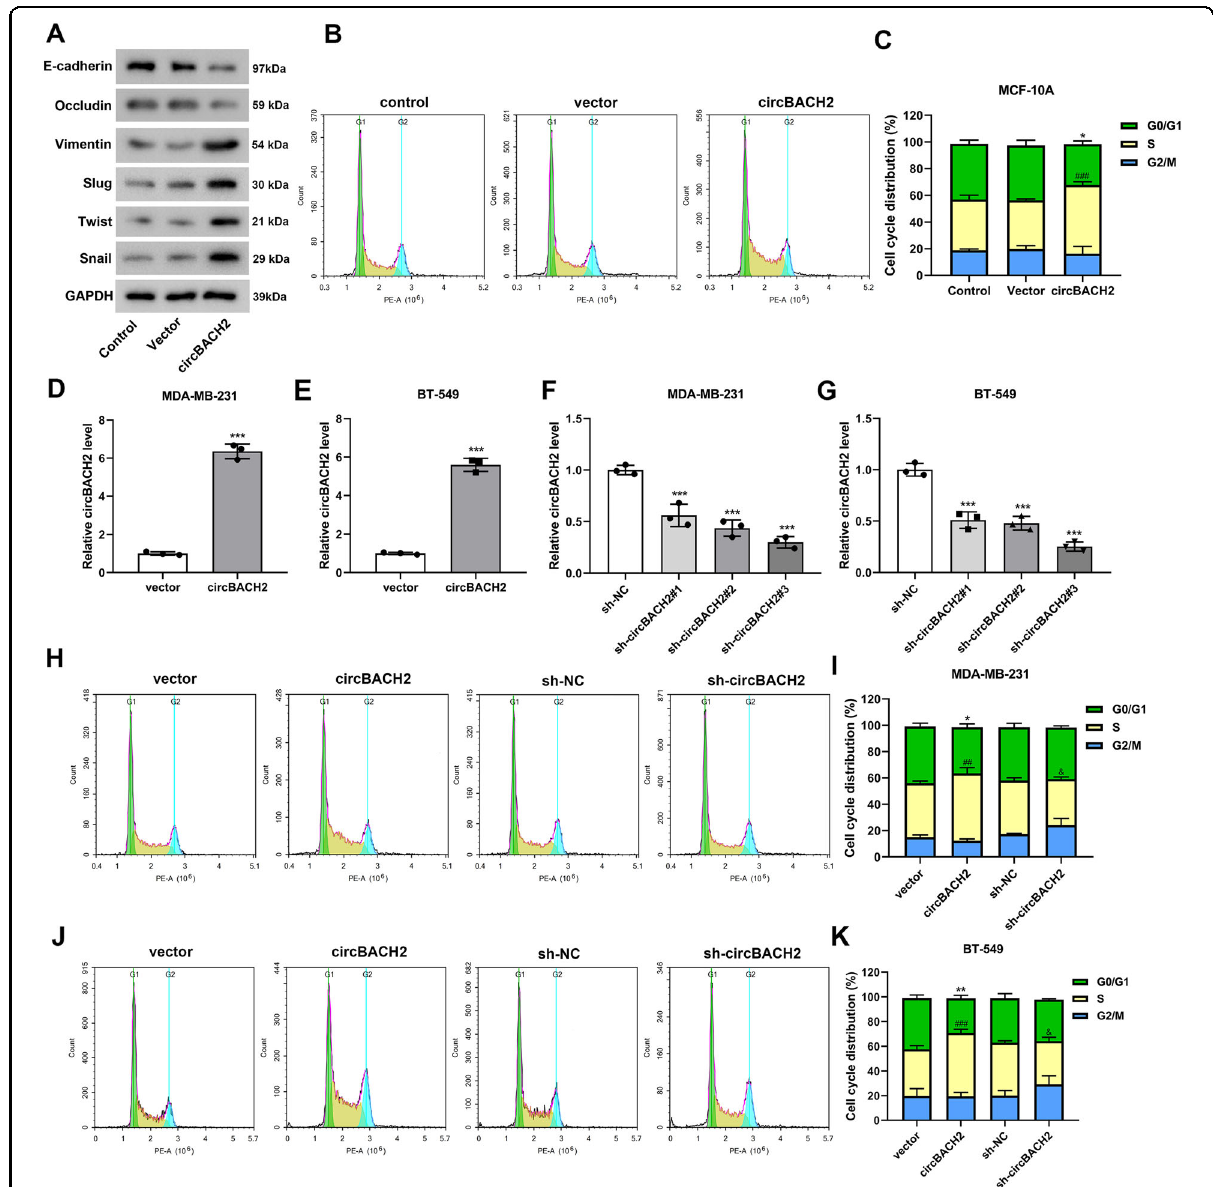
Fig. 2 The oncogenic potential of circBACH2. A , B MCF-10A cells were transfected with the overexpression vector of circBACH2 (circBACH2) or mock vector (vector). A The protein levels of E-cadherin, Occludin, Vimentin, Slug, Twist, and Snail were measured by western blot. B , C Flow cytometry determined the relative cell numbers in each cell-cycle phase. * P < 0.05 vs G0/G1 phase of vector group; ### P < 0.001 vs S phase of vector group. D , E The transfection ef fi ciency of the overexpression vector of circBACH2 was measured by qRT-PCR in TNBC cell lines. *** P < 0.001 vs vector. F , G The transfection ef fi ciency of sh-BACH2#1, #2, and #3 was measured by qRT-PCR in TNBC cell lines. The sh-NC served as a negative control. *** P < 0.001 vs sh-NC. H – K Flow cytometry determined the relative cell numbers in each cell-cycle phase in the MDA-MB-231 and BT-549 cells that were transfected with indicated vectors. * P < 0.05, ** P < 0.01 vs G0/G1 phase of vector group; ## P < 0.01, ### P < 0.001 vs S phase of vector group; and & P < 0.05 vs S phase of sh-NC